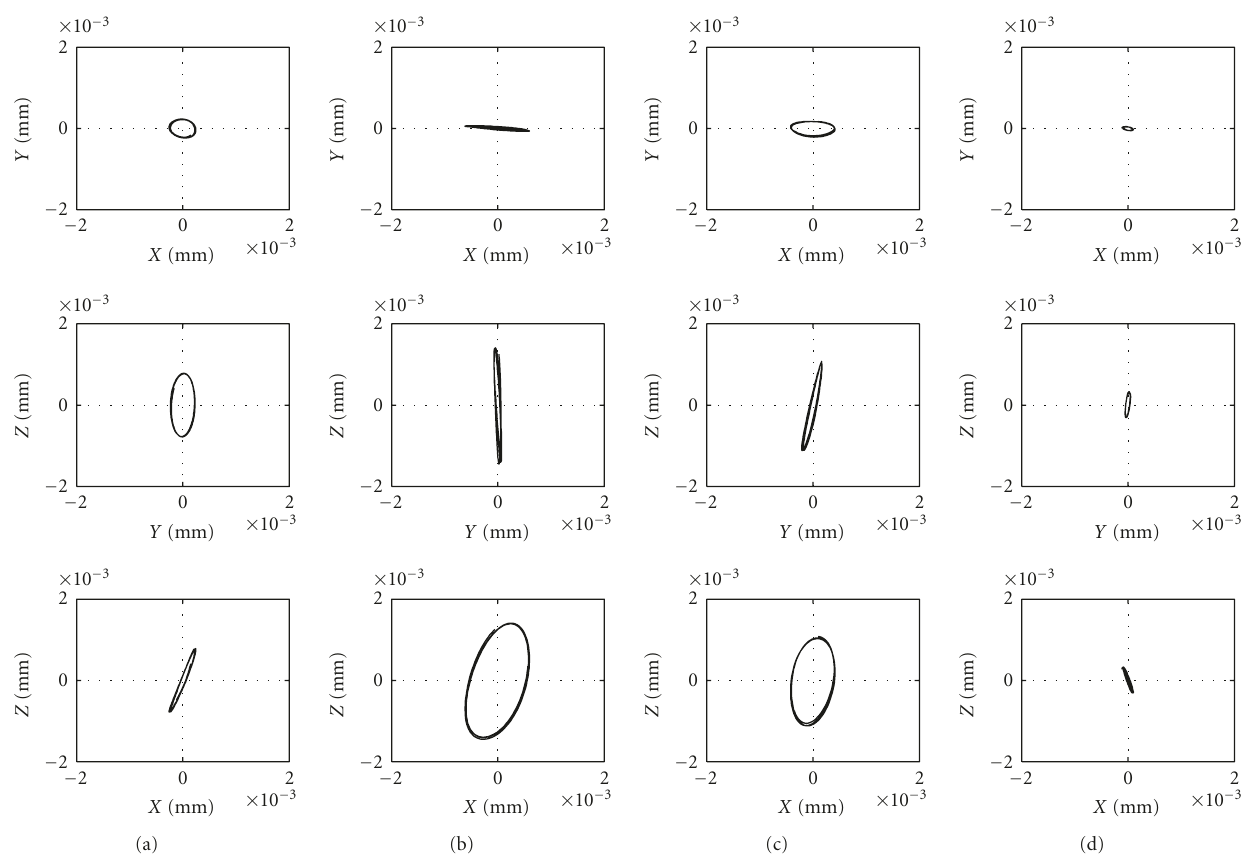
Figure 5: An example of the RF muscle belly trajectories over the ( x , y ), ( y , z ) and ( x , z ) planes, at di ff erent stimulation frequencies ((a) = 16Hz, (b) = 25 Hz, (c) = 40Hz, (d) = 50 Hz). The figure corresponds to P1 subject